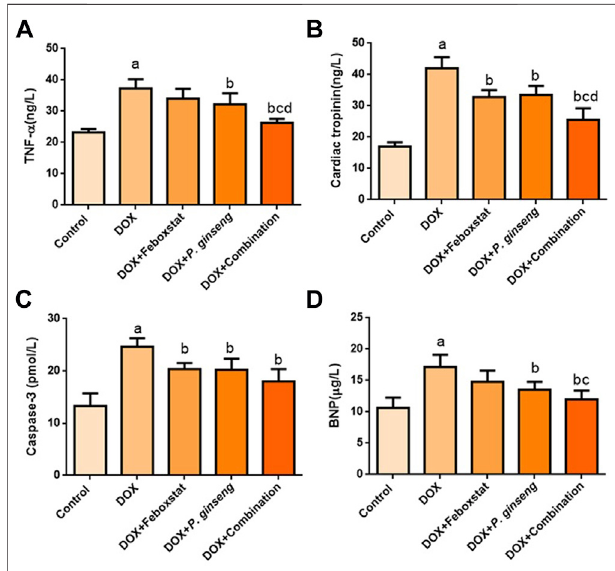
FIGURE 1 | Effects of drug treatments on (A) Serum TNF- α level, (B) Cardiac Tropinin level (C) Serum Caspase-3 level, and (D) Serum BNP level.